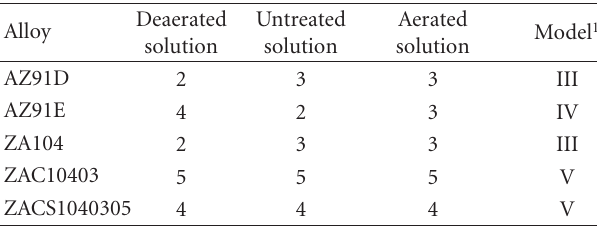
Figure 2: Time variation of E corr for (a) ZA104, (b) ZAC10403, and (c) ZACS1040305 in untreated, aerated, and deaerated 5% NaCl solution saturated with Mg(OH) 2 at pH 9 and 25 ◦ C. Table 3: Approximate i corr values ( μ A · cm − 2 ) for the AZ and ZA magnesium alloys calculated from the potentiodynamic curves by the method of linear